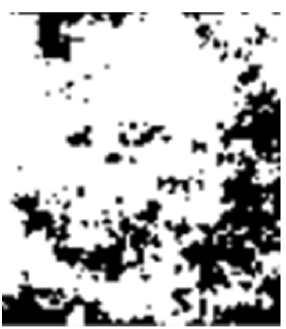
Figure 18. The binary version of the image in the yellow box.